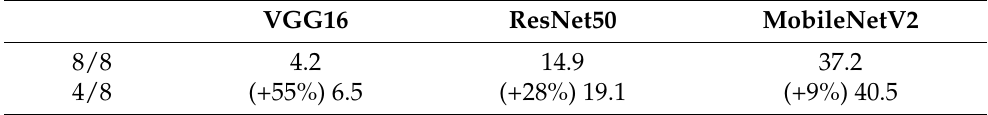
Table 7. Simulated speeds of models with 8 bit weights and 4 bit weights for an Intel Arria 10 FPGA with 1024 multiply-accumulate DSP cores and a 32 bit-wide bus to external RAM memory. Values are in Frames Per Second